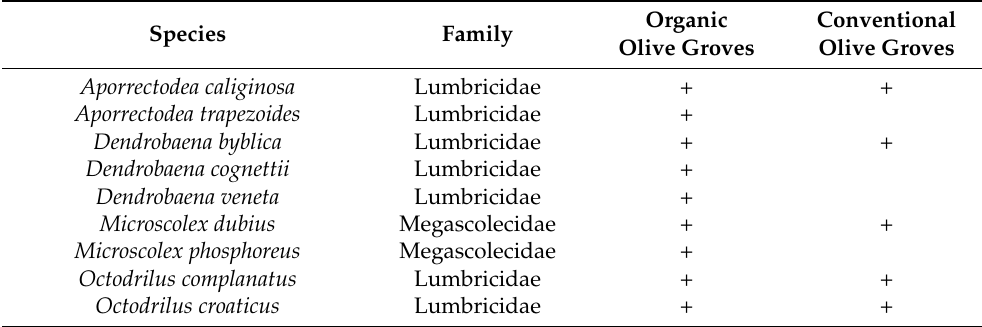
Table A5. Earthworms species recorded in organic and conventional olive groves. Species nomencla- ture based on Graf (1955); Zicsi (1991); Christian and Ziscs (1999)